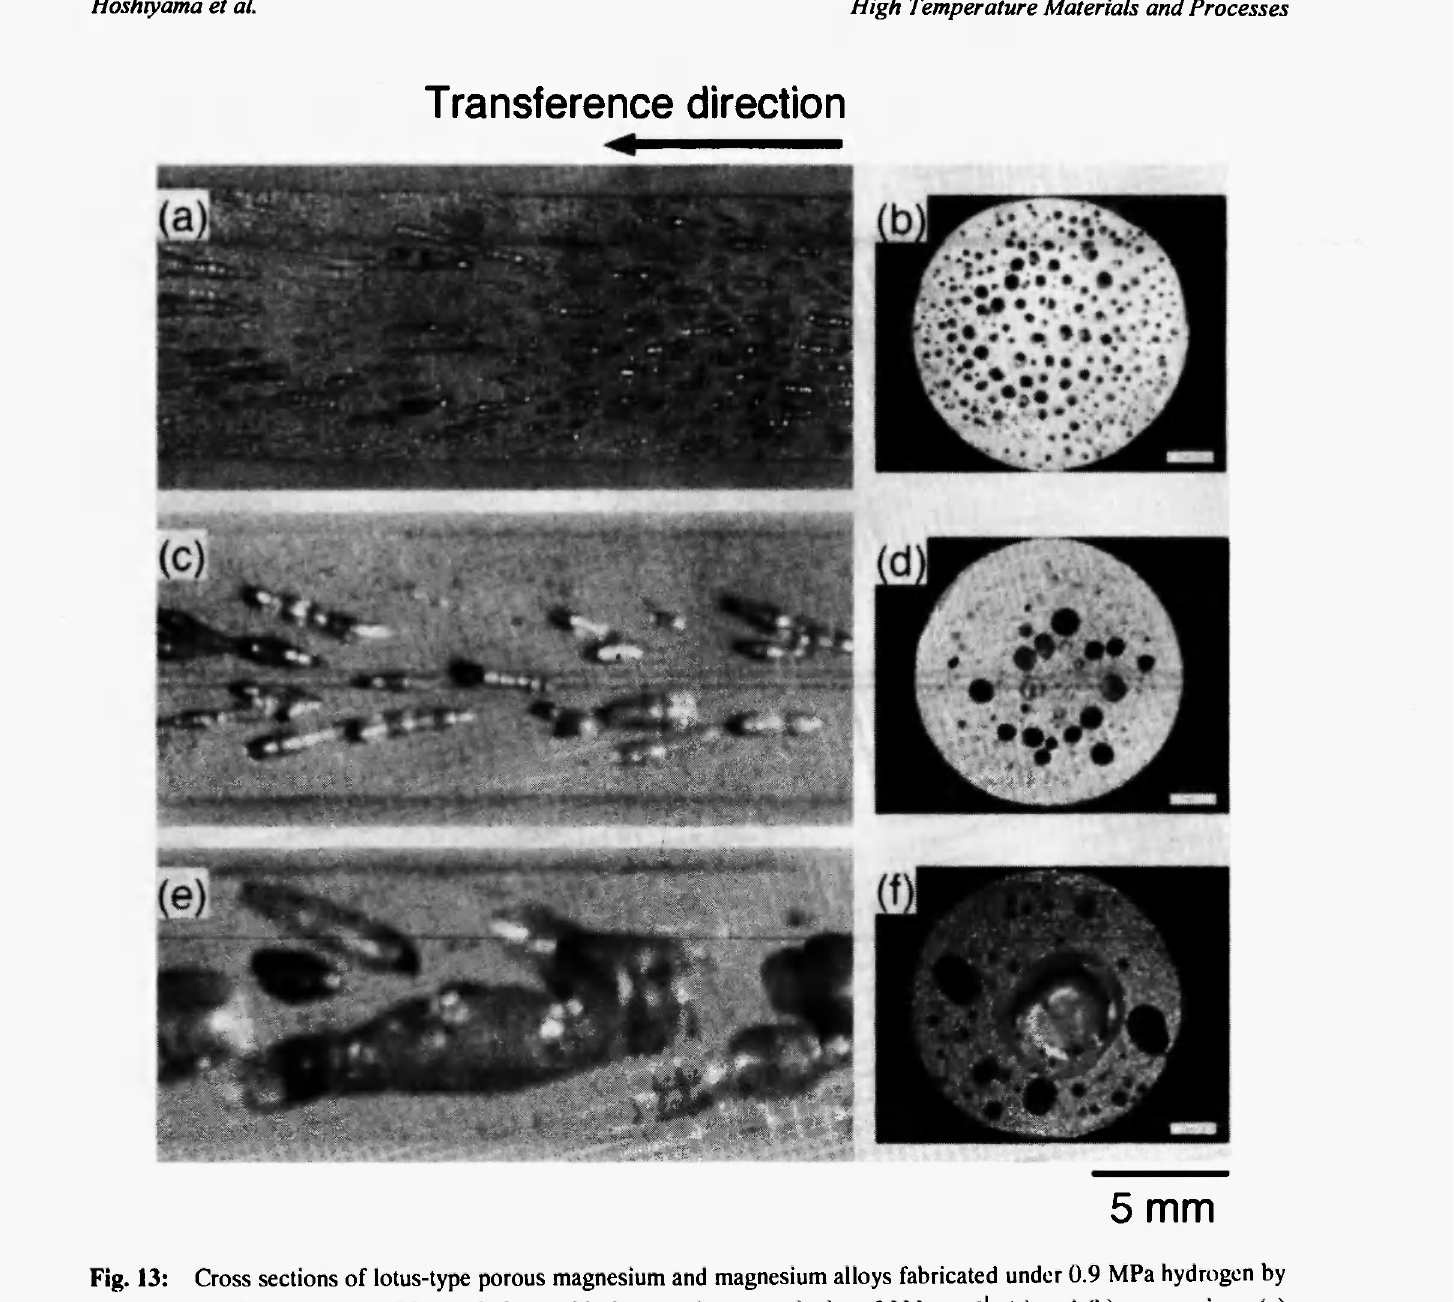
Cross sections of lotus-type porous magnesium and magnesium alloys fabricated under 0.9 MPa hydrogen by continuous zone melting technique with the transference velocity of 330 μηιβ"'. (a) and (b): magnesium, (c) and (d): AZ31B, (e) and (f): AZ91D. Pictures on left hand side ((a), (c) and (e)) are of sections parallel to transference direction and those on right hand side ((b), (d) and (0) are of sections perpendicular to transference direction. Ambient gas was blown to the portion of the sample rod right below the heated zone using an electric fan with electric voltage of 40 V.